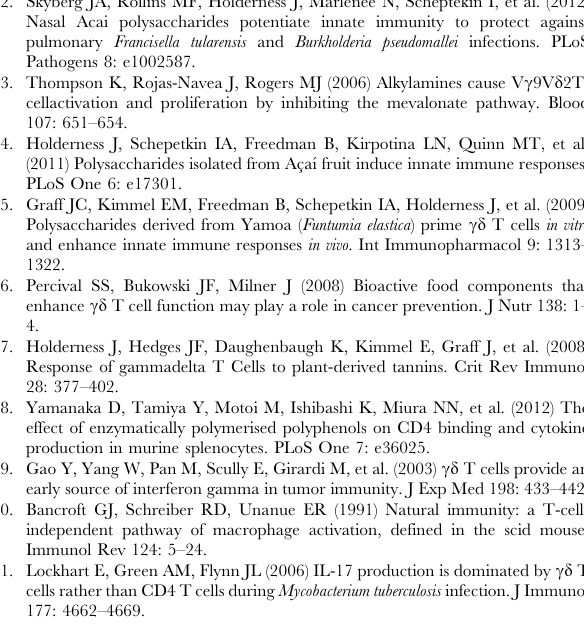
Figure S2 Effect of monocyte and cd T cell depletion on oenothein B-priming of bovine PBMCs. Bovine PBMCs (10 5 cells/well) were depleted of (A) monocytes or (B) cd T cells and treated with 20 m g/ml oenothein B or X-VIVO medium alone for 24 hrs. Cells were then washed and treated with 10 ng/ ml rhu IL-18 or medium alone for 18 hrs. After incubation, IFN c levels in the supernatant fluids were measured by ELISA. The data are expressed as mean + / 2 SEM of three independent experiments comparing depleted PBMCs to un-depleted controls tested concurrently. All samples were tested in duplicate or triplicate. Statistical significance was measured by Two-way ANOVA with Bonferroni post-test. *p , 0.05, **p , 0.01, ***p ,